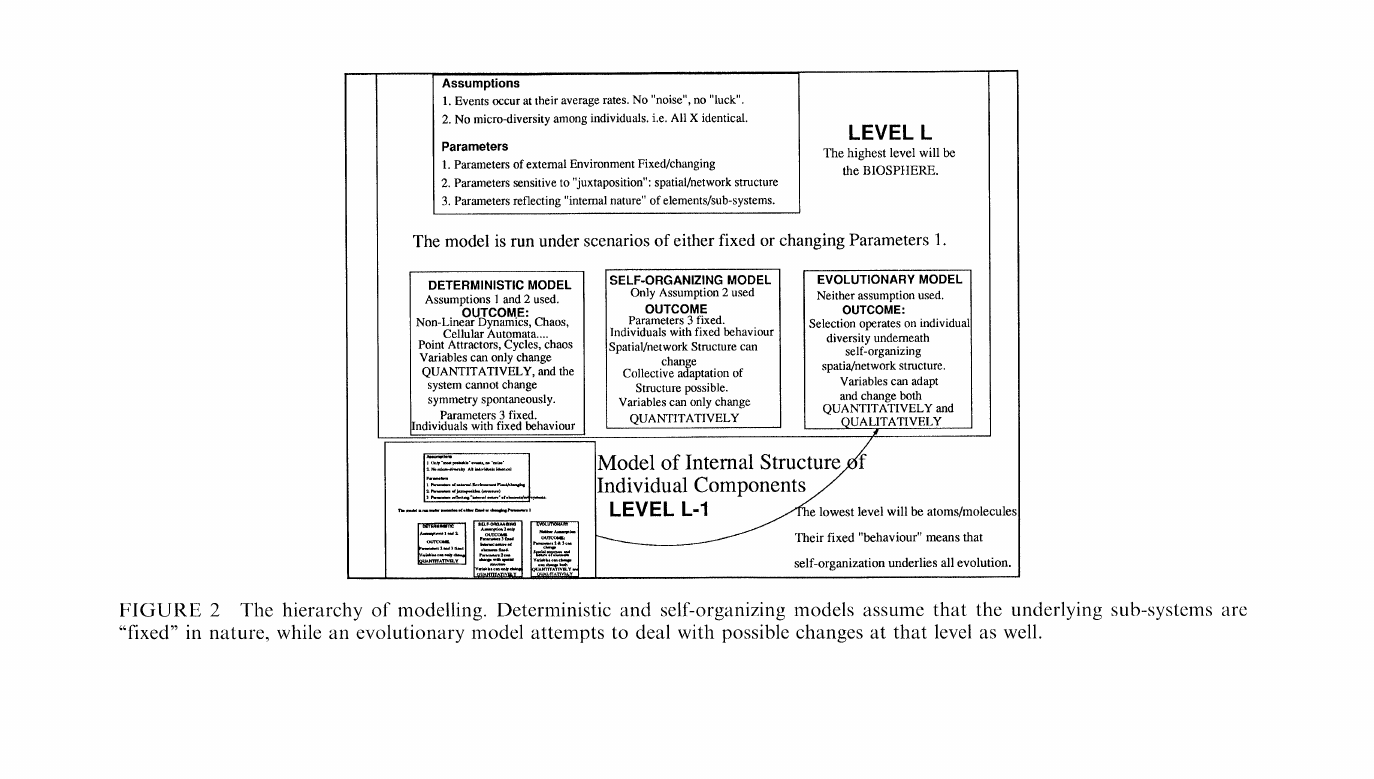
FIGURE 2 The hierarchy of modelling. Deterministic and self-organizing models assume that the underlying sub-systems are "fixed" in nature, while an evolutionary model attempts to deal with possible changes at that level as